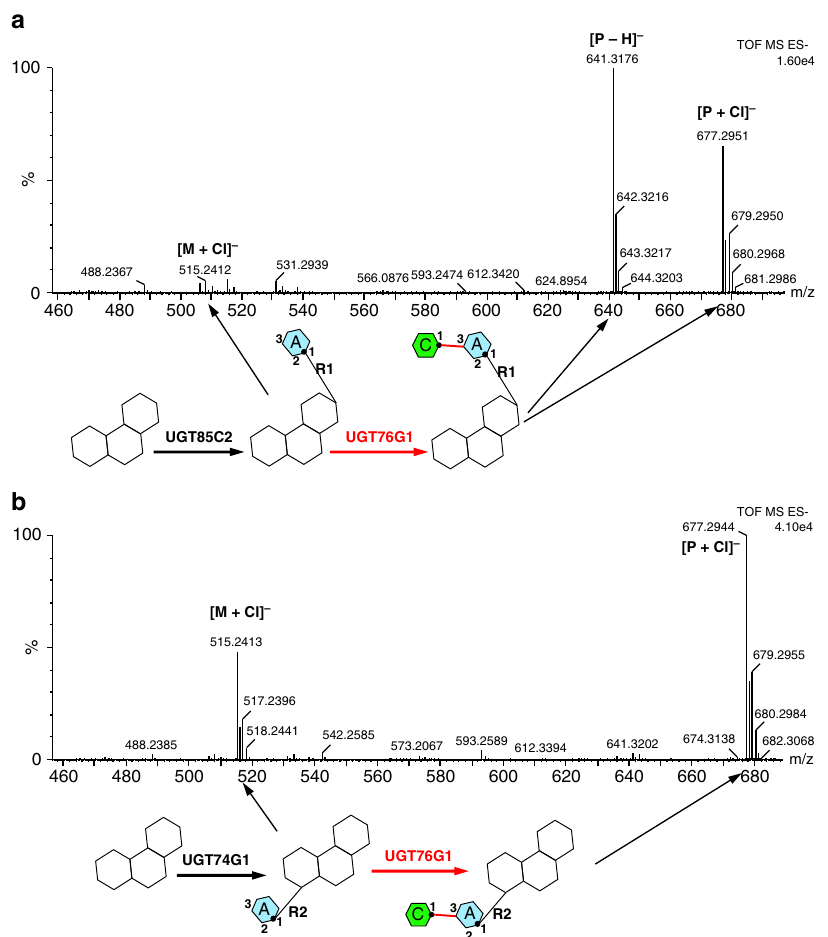
Fig. 4 The reactions of steviol monoglucosides by UGT76G1. Direct MS of the single sugar transfer at R1 ( a ) and R2 position ( b ) of two self-made steviol monoglucosides. The reaction of the steviol monoglucoside was catalyzed by 0.03 mg ml − 1 UGT76G1 (1×) for 18 h. The reaction schemes to synthesize steviol monoglucosides and the single sugar transfer catalyzed by UGT76G1 are shown. The main negative ions derived from the products are labeled and related to the chemical compounds in the reaction schemes. The reaction conditions for these two self-made steviol glucosides are identical, and the relative contents of the substrate (M) and the product (P) show the preferred reaction at the R1